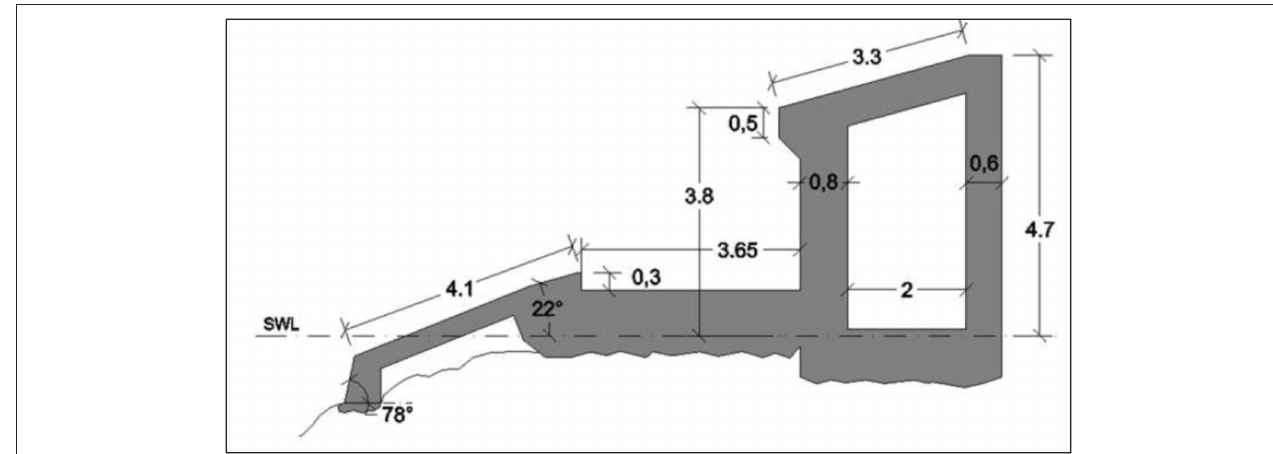
FIGURE 1 | OBREC cross-section (from Contestabile et al., 2016).